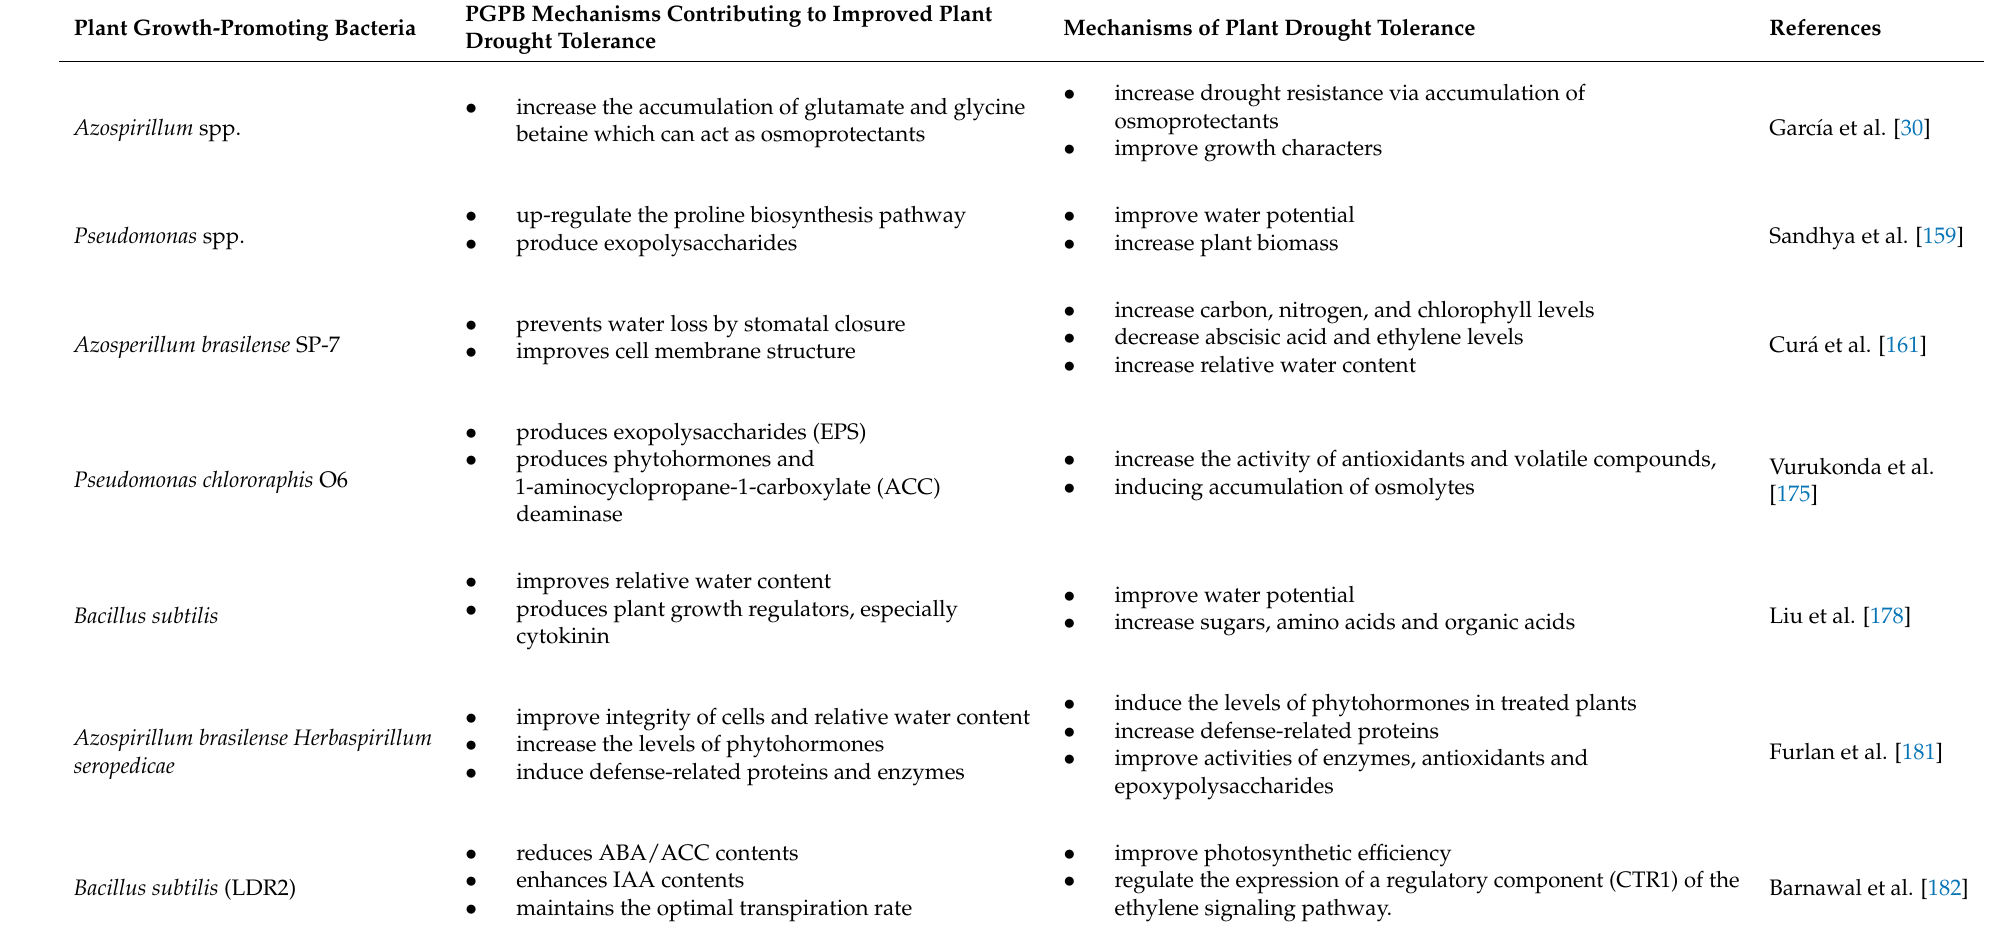
Table 1. Role of different plant growth-promoting bacteria (PGPB) in induction of plant drought tolerance